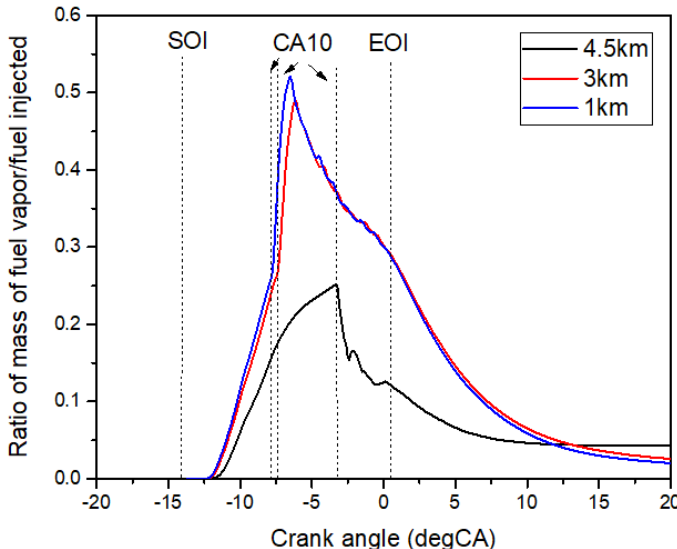
Figure 18. Ratio of mass of fuel vapor/injected fuel at various altitudes.